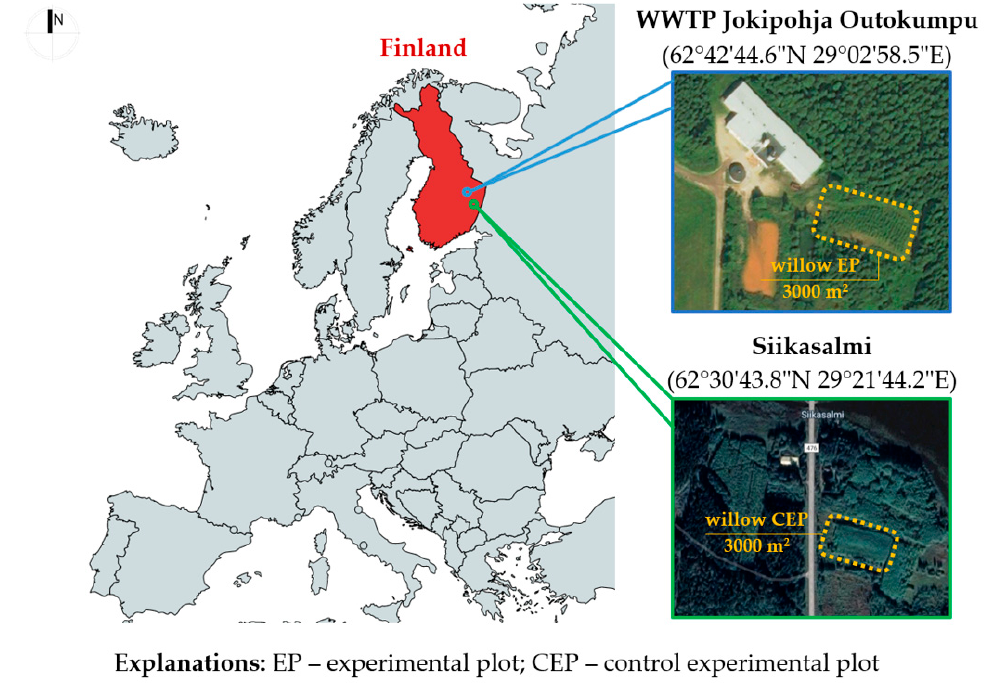
Figure 1. The location of wastewater treatment plant (WWTP) and willow experiment plot (EP) in Jokipohja Outokumpu and control experimental plot (CEP) in Siikasalmi.